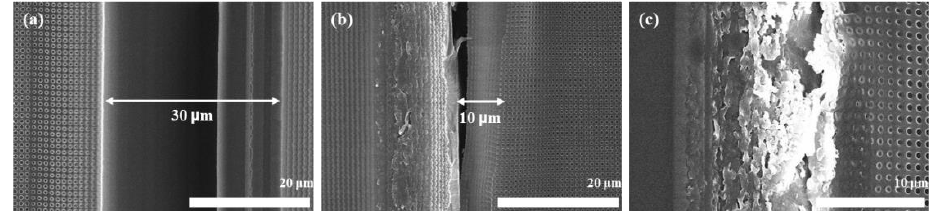
Figure 7. Stitch gap displacement by ( a ) 10 mm, ( b ) 9.97 mm, and ( c ) 9.95